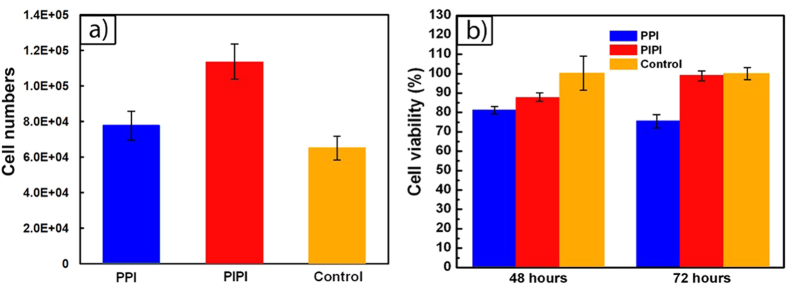
Results from in vitro HSF cells experiments:(a) cell count after 24 h of incubation, and (b) cell viability after 48 and 72 h of incubation in contact with PPI and PIPI samples.